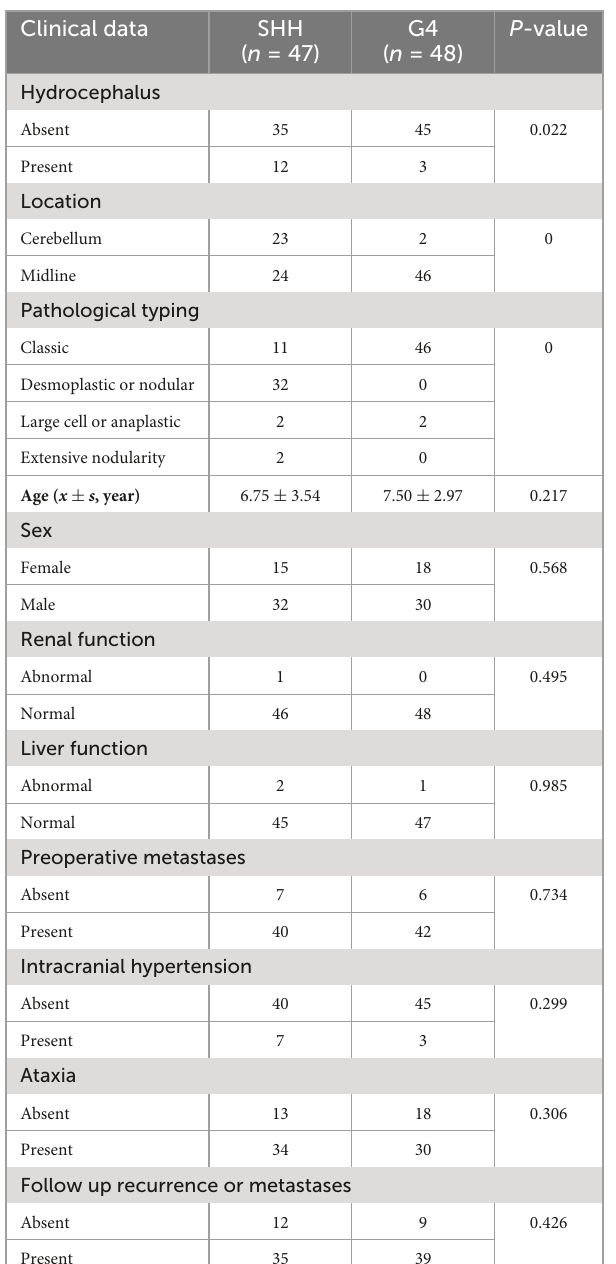
TABLE 1 Clinical information of SHH and G4 groups. TABLE 2 Seventeen optimal radiomic